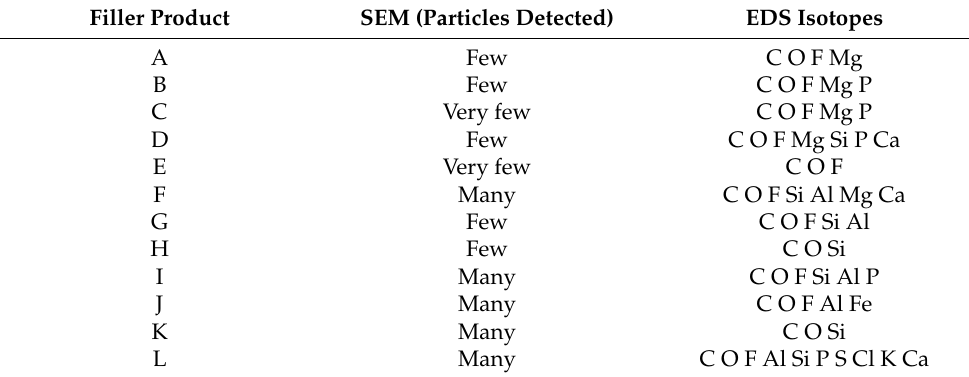
Table 2. Scanning electron microscopy (SEM) and energy-dispersive X-ray spectrometry (EDS) analysis of filler